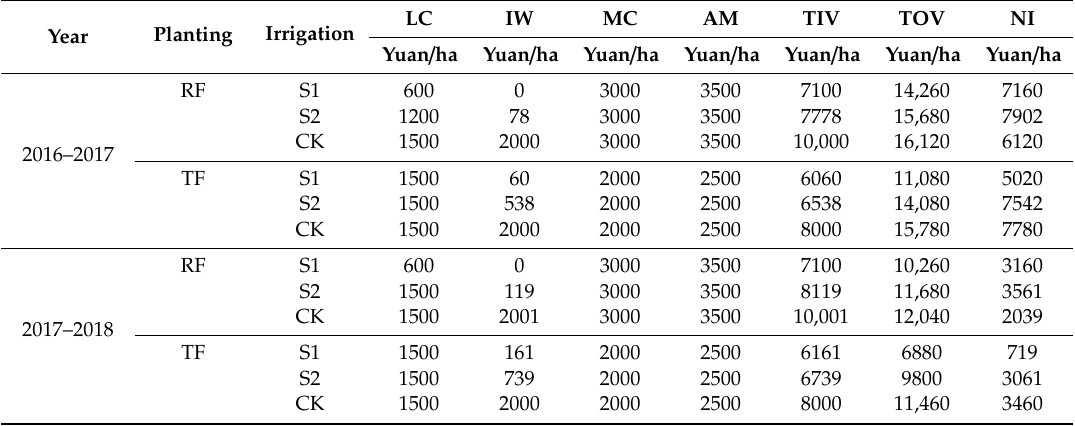
Table 4. Economic benefits of two planting systems and three irrigation